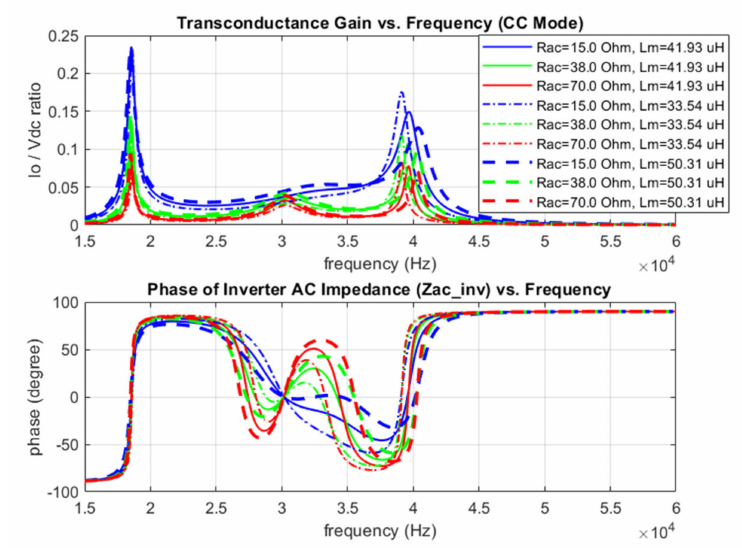
Figure 6. DC transconductance gain and inverter power factor angle with respect to DAB switching frequency change.